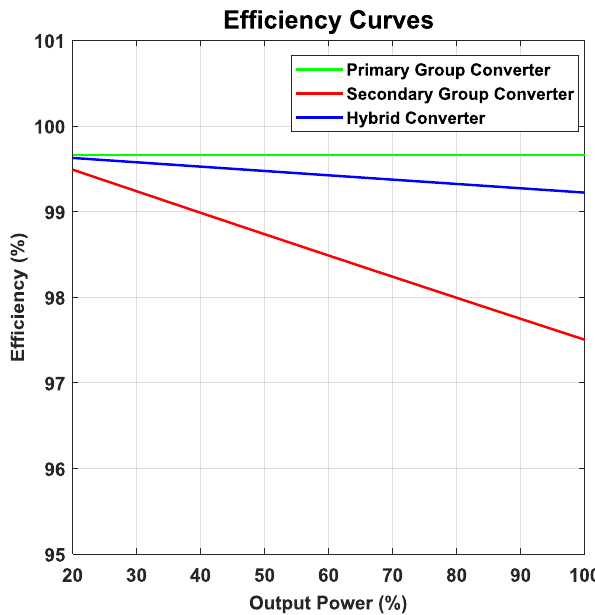
Figure 7. Hybrid E ffi ciency loss curve with respect to power Figure 7. Hybrid Efficiency loss curve with respect to power loading.